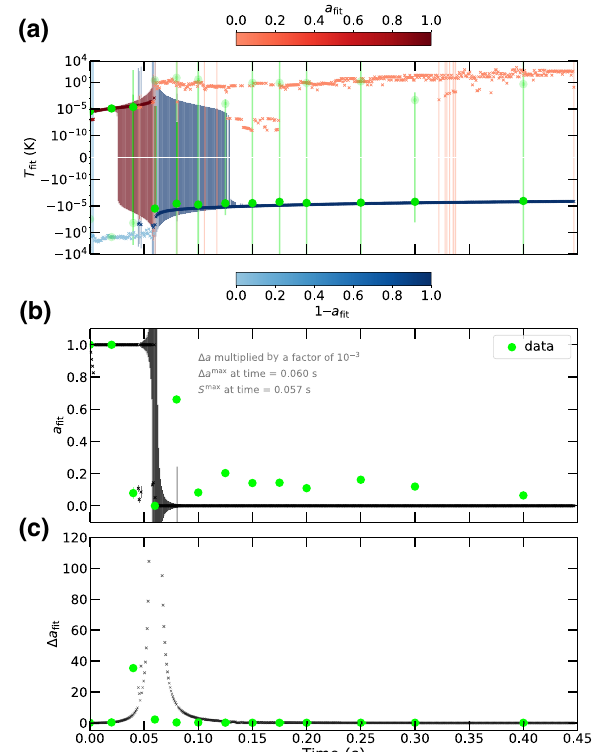
FIG. 6. The Cs population fitted by a combination of Boltz- mann distributions with negative and positive temperatures. (a) The fitted temperature over the heating time. Our engine shows a thermal behavior for short times until it reaches the transition from positive to negative temperature at roughly 60 ms, corre- sponding to maximum entropy. Further away from this area, the system can be described by an almost exclusively positive (neg- ative) temperature for short (long) heating times. (b),(c) The fit parameter a (b) with its width (cid:2) a fit (c). The green dots show data and the colored lines simulations.